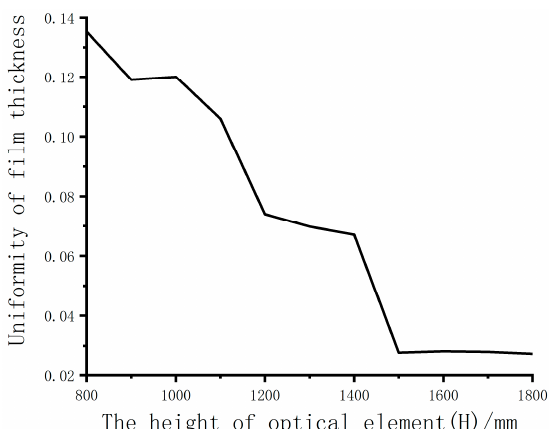
Figure 11. Film thickness uniformity versus the height of the optical element. The height repre- sents the position of the top of the concave optical element.